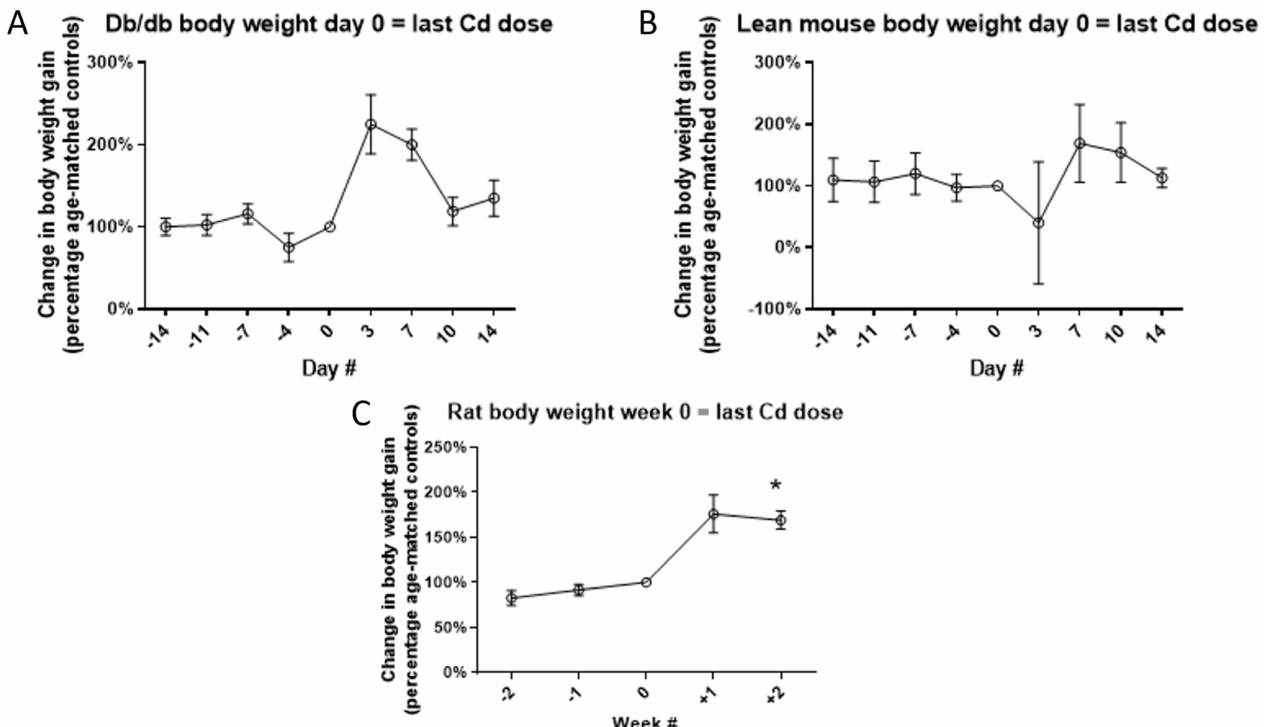
Figure 3. Changes in individual body weight during two weeks of 0.6 mg/kg/b.w./day of Cd